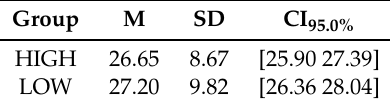
Table A4. Channels’ counts: EC HIGH and LOW stress-susceptible groups. Mean (M), standard deviation (SD), median (Mdn), and 95.0% confidence interval (CI 95.0% ) associated with bootstrap